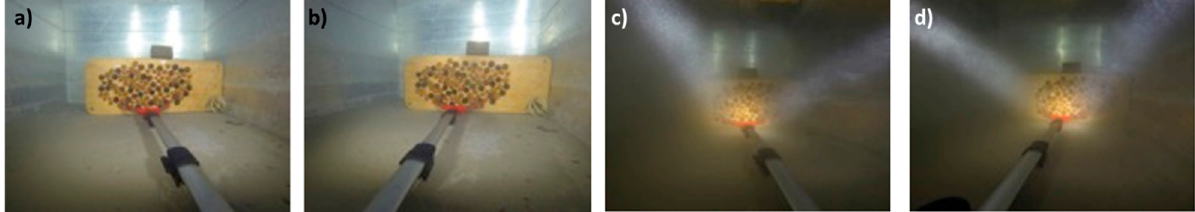
Figure 5. Photographs of artificial colonization for flood light 58 cm ( a , b . left) and spot light 65 cm ( c , d . right). ( a ) Left camera, flood, 58 cm; ( b ) right camera, flood, 58 cm; ( c ) left camera, spot, 65 cm; ( d ) right camera, spot, 65 cm.